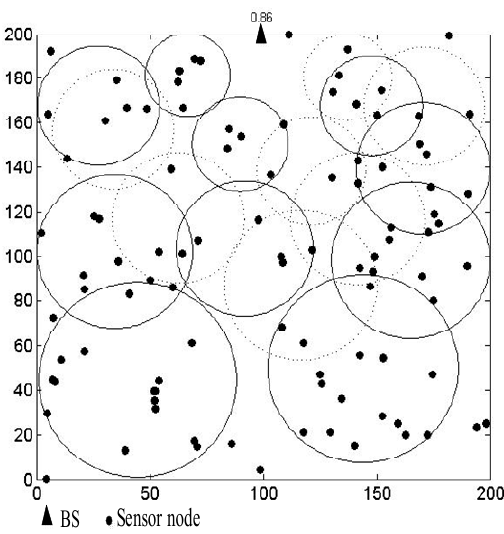
Figure 7. The circular area distribution of the proposed algorithm in the simulation experiment.